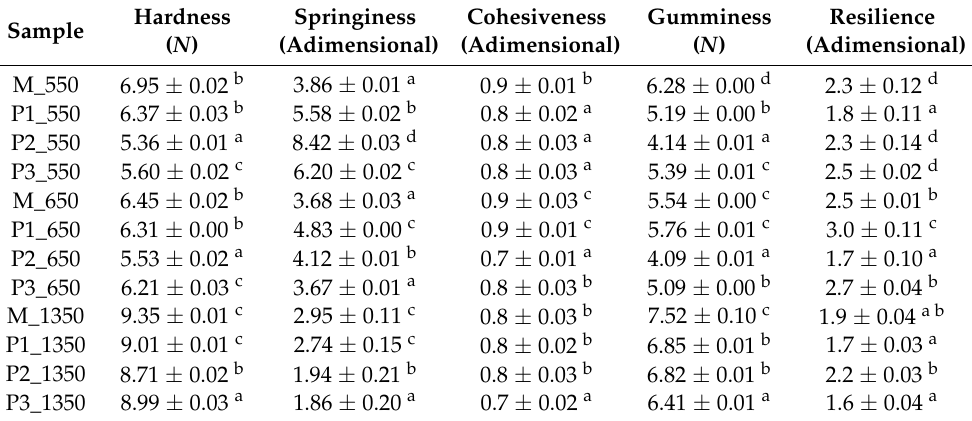
Table 2. Texture parameters of the bread samples with different percentages of hemp seed oil added. Sample